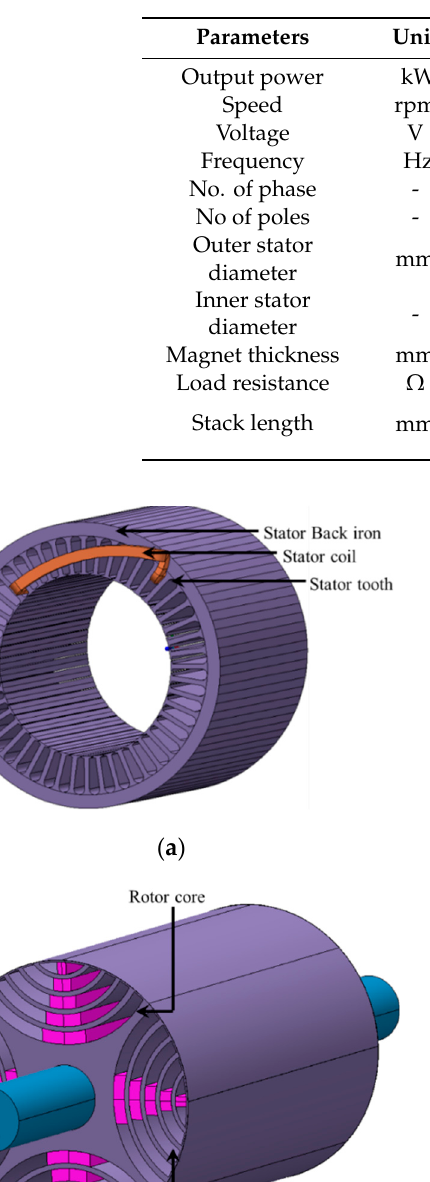
Table 2. Design requirements.